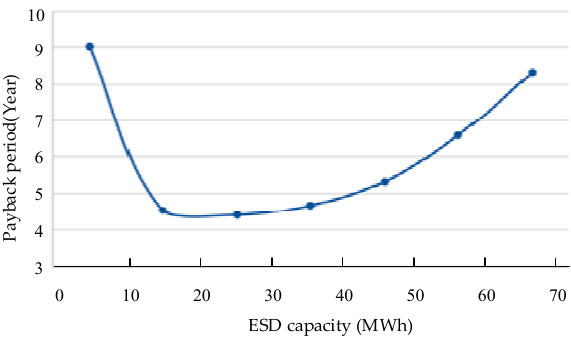
Figure 12. The correlation between payback period and ESD capacity.